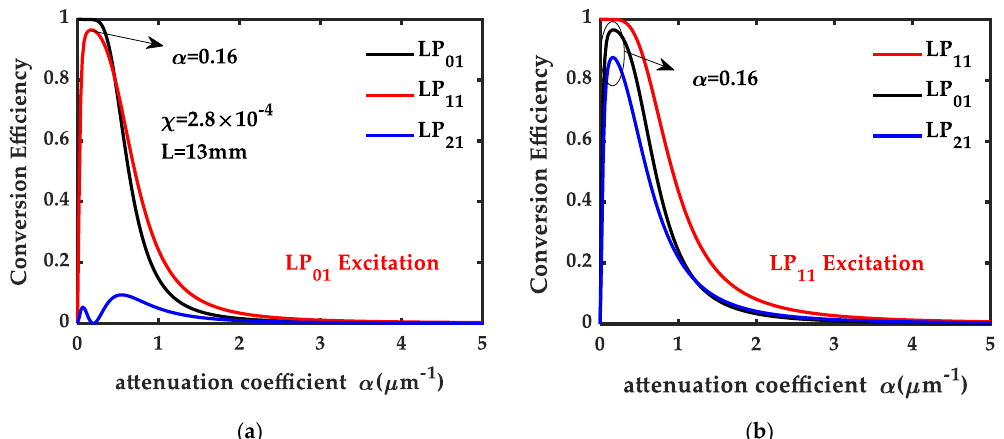
Figure 6. The conversion efficiencies versus attenuation coefficient α when excitation was ( a ) LP 01 mode and ( b ) LP 11 mode.